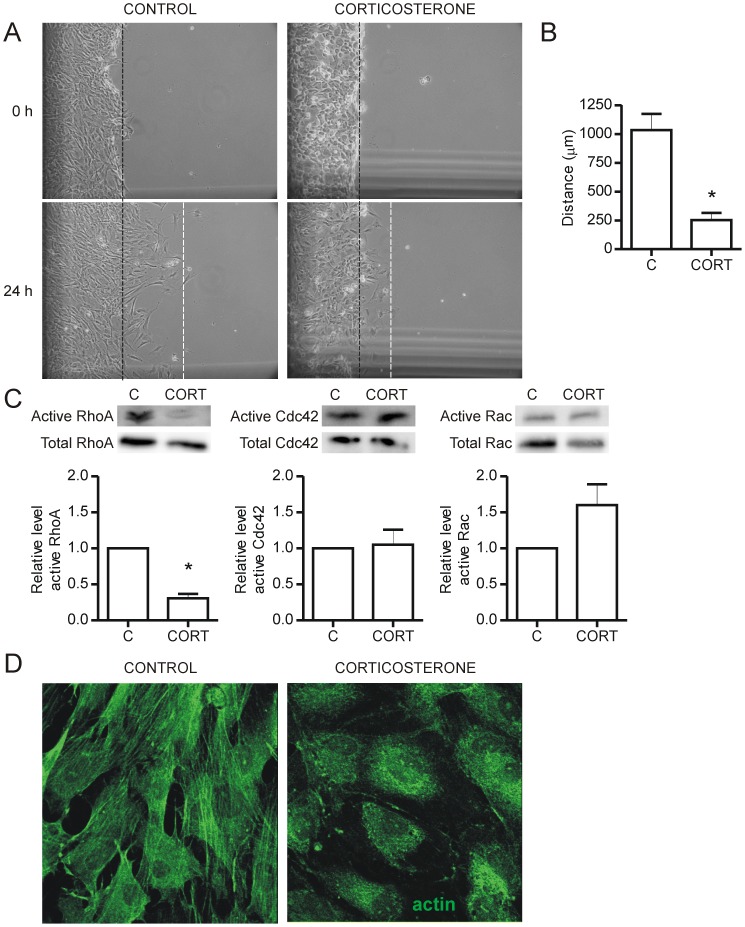
Corticosterone inhibits endothelial cell migration.Endothelial cells (2.0×106) were plated in 60 mm2 plates coated with 1.5% gelatin and treated with 600 nM corticosterone for 48 hours. Cells were pretreated with 5 µg/ml Mitomycin C for 2 hours prior to removing cells from half of the dish using a rubber cell scraper. Cells then were allowed to migrate into the scrape area for 24 hours (A). The dashed black line denotes the edge of the scrape at time 0, and the dashed white line denotes migration front after 24 hr. Migration distance was calculated as the difference between white and black lines in each field of view. Corticosterone inhibited migration of endothelial cells into the scrape area (*p<0.0001 vs. control, n = 11 measurements from 3–4 fields of view) (B). RhoGTPase activity assays were performed using PAK or Rhotekin coated beads on endothelial cells pre-treated with 600 nM corticosterone for 48 hours then plated on type I collagen for 2 hr prior to lysis. Western blots were performed for RhoA, Cdc42 and Rac1 (*p = 0.008 vs. control, n = 3 independent experiments) (C). Corticosterone treated cells were stained with FITC-Phalloidin to visualize actin. Stress fibers were not observed with corticosterone treatment (D). C – Control, CORT – Corticosterone.